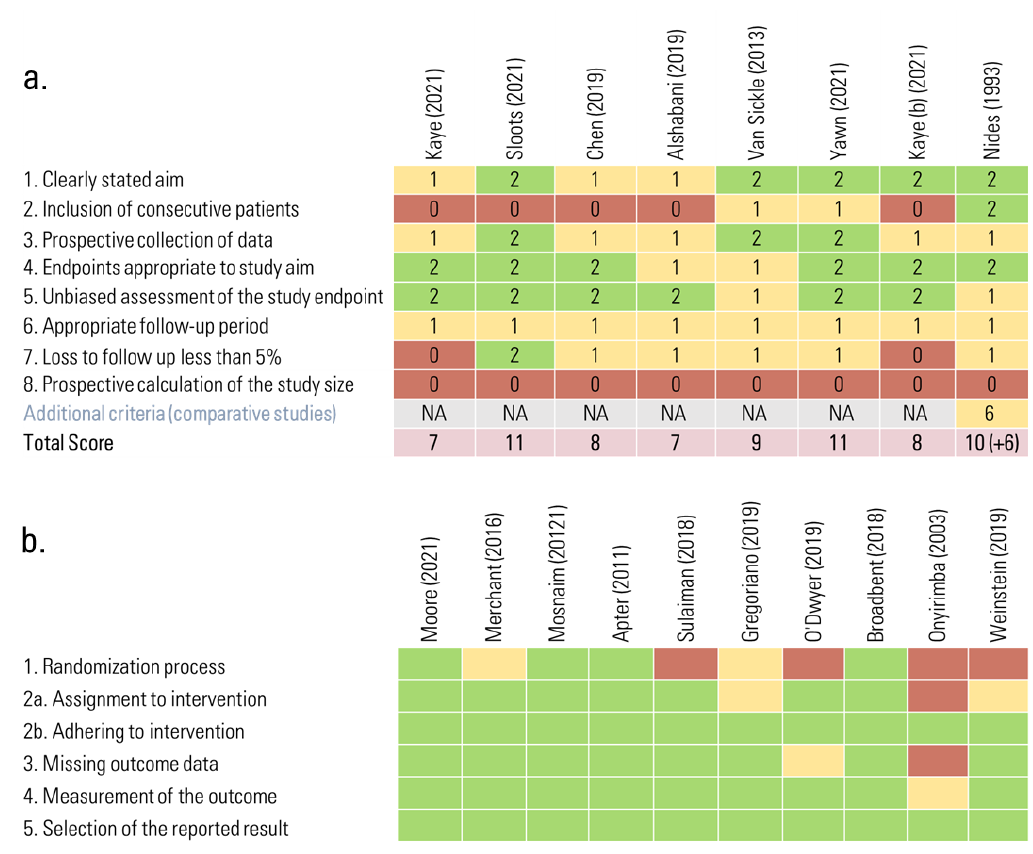
Figure 5. Adherence outcomes up to 3 months . References: 53, 58, 61.